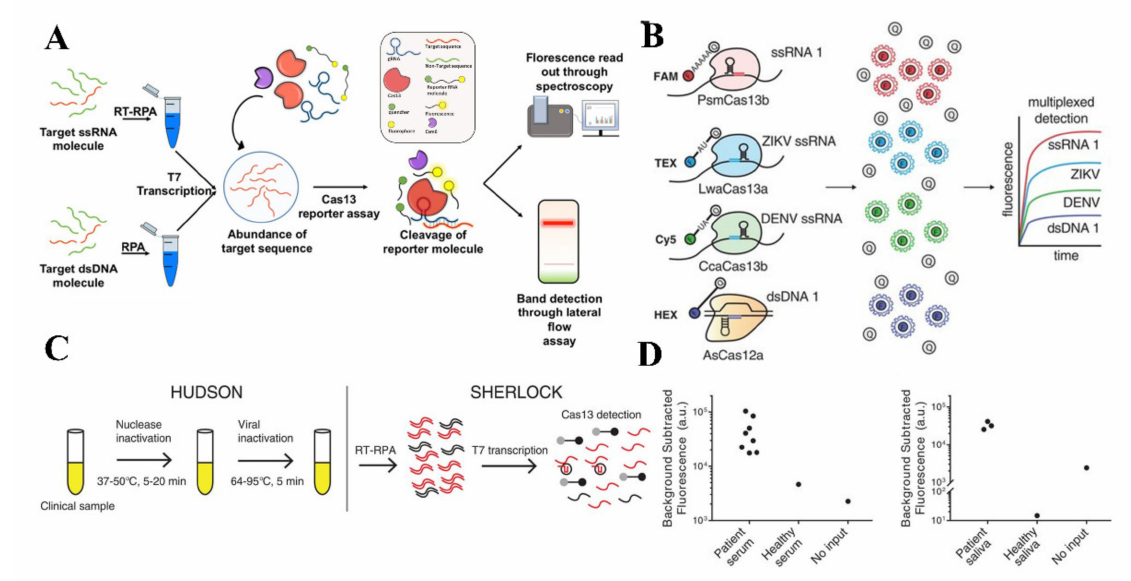
Figure 9. Detection of DENV using CRISPR-Cas based assays. ( A ) Graphical representation of SHERLOCK for detecting nucleic acids (reprinted from [215]). ( B ) Detection of in-sample four-channel multiplexed targets using SHERLOCK version 2 (Reprinted with permission from ref. [216]. Copyright 2018 The American Association for the Advancement of Science.). ( C , D ) The detection principle of clinical viral specimens from serum or saliva combining HUDSON and SHERLOCK (Reprinted with permission from ref. [217]. Copyright 2018 The American Association for the Advancement of